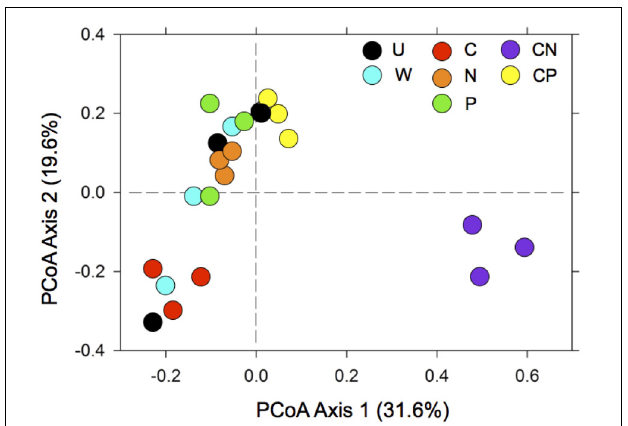
FIGURE 2 | The addition of resources contributed to shifts in bacterial composition with the most dramatic change occurring in CN soils. For treatment abbreviations see Table 1 . Treatments abbreviations include: C as mannitol (C), N as NH 4 + and NO 3 - (N), P as Na 3 PO 4 (P), C and N (CN), C and P (CP), water only (W), and an un-amended control (U). The multivariate ordination was generated using principle coordinate analysis (PCoA) on a sample × OTU matrix of 16S rDNA community libraries (97% similarity cut-off).